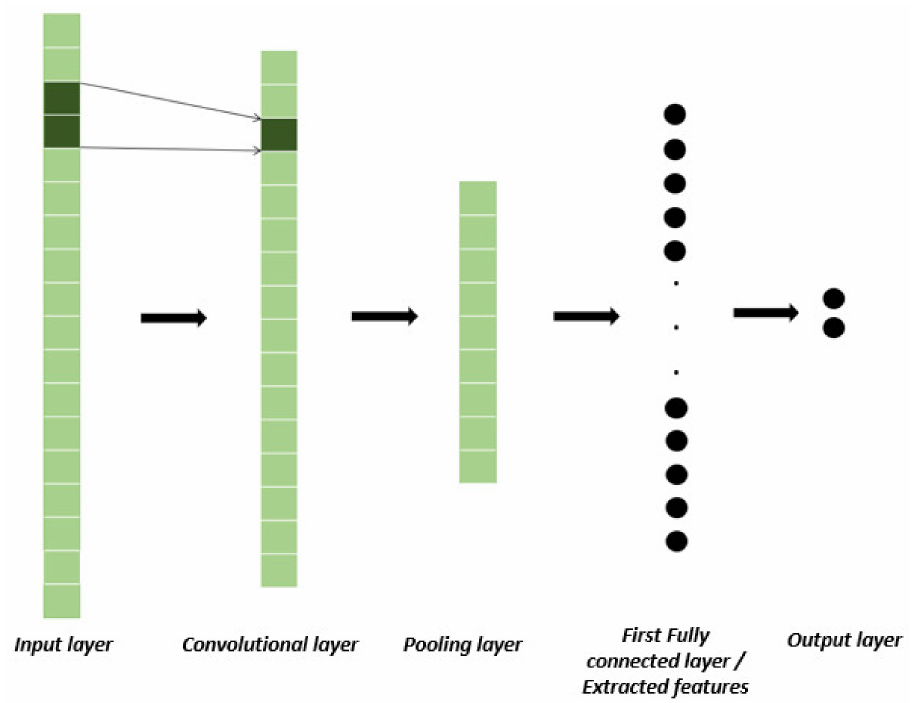
Figure 5. Illustration of 1-Dimension Convolutional Neural